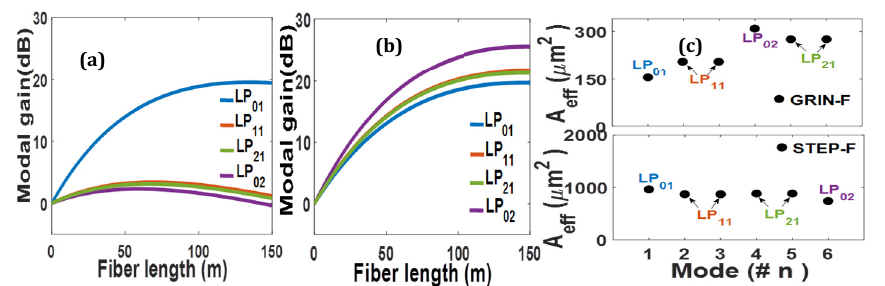
Figure 2. ( a , b ) Variation of modal gain for all modes in the GRIN-F and the STEP-F, respectively, ( c ) and the effective area of